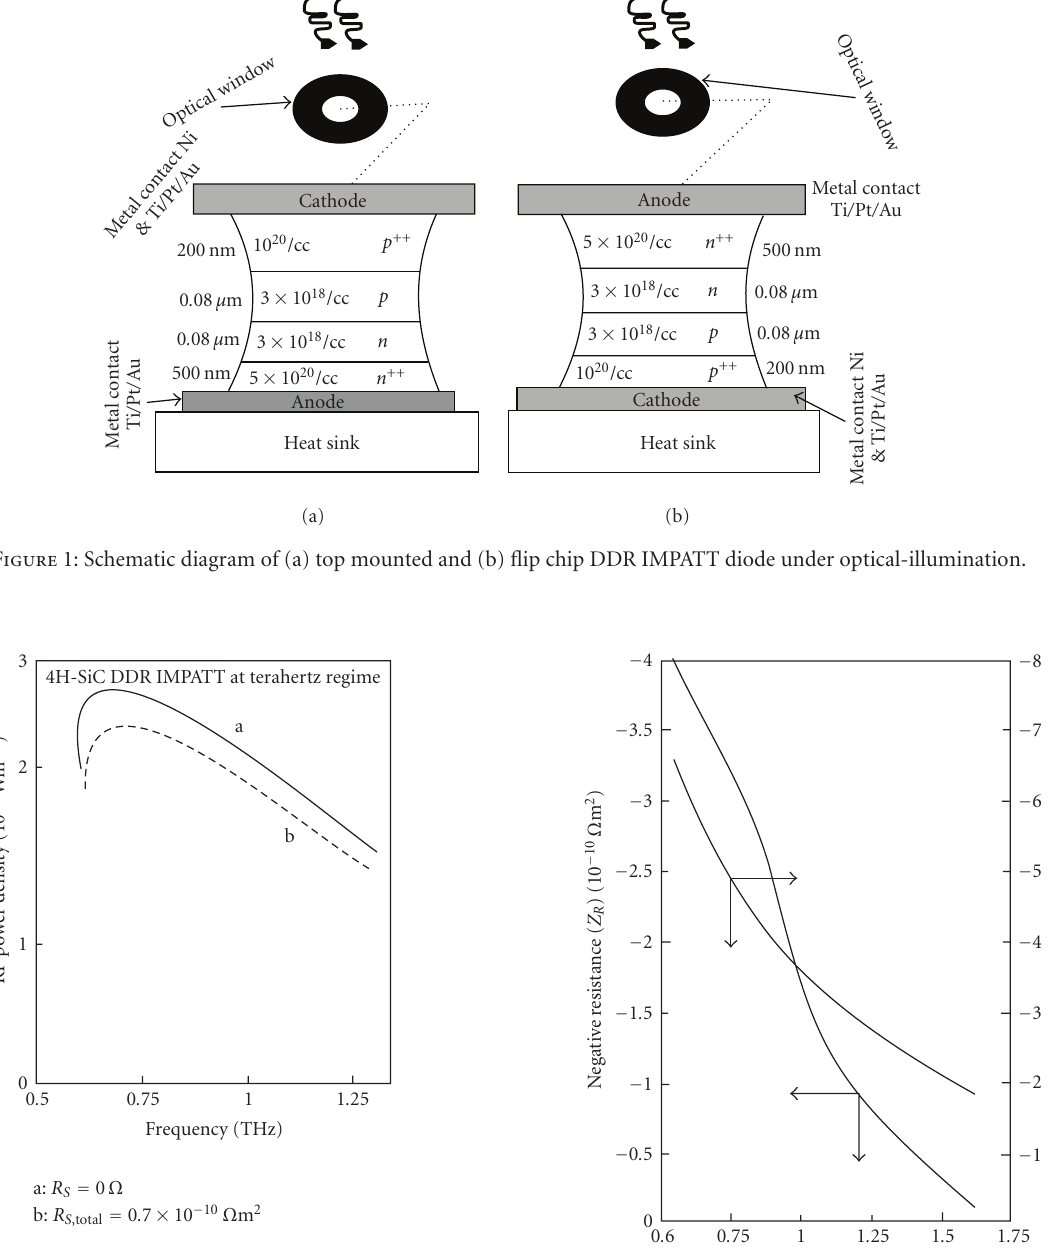
Figure 2: E ff ect of series resistance on RF power density of 4H-Sic Terahertz IMPATT diode.